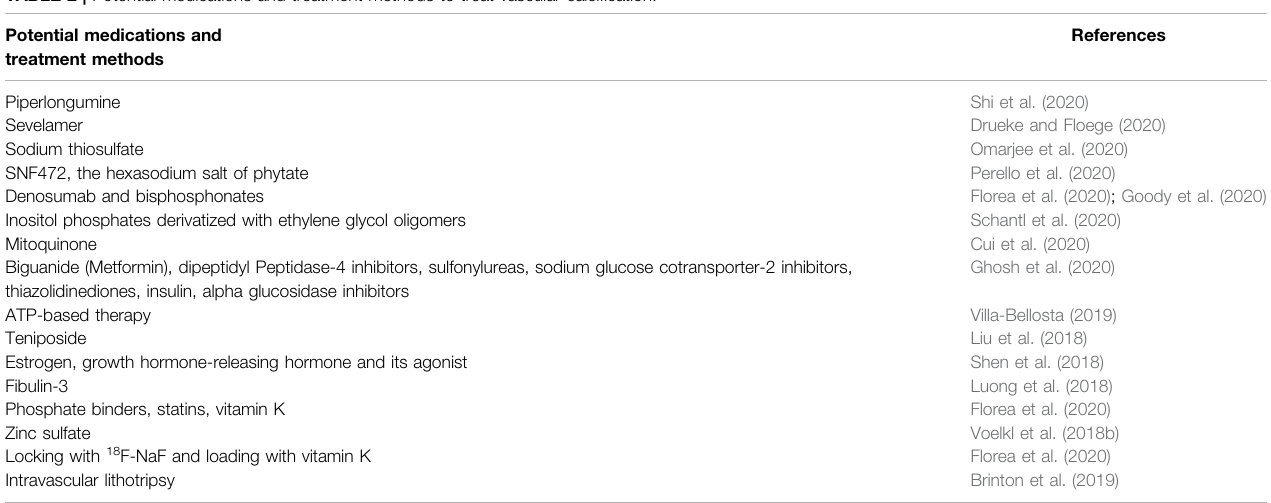
TABLE 2 | Potential medications and treatment methods to treat vascular calci fi cation. Potential medications and treatment